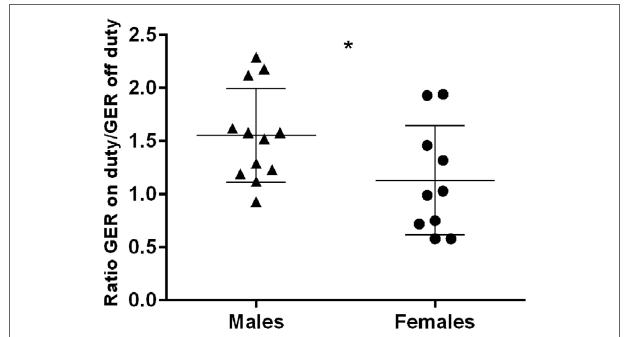
FigUre 4 | Ratio GER on duty/off duty in males and females; horizontal bars indicate mean and SD; * p <